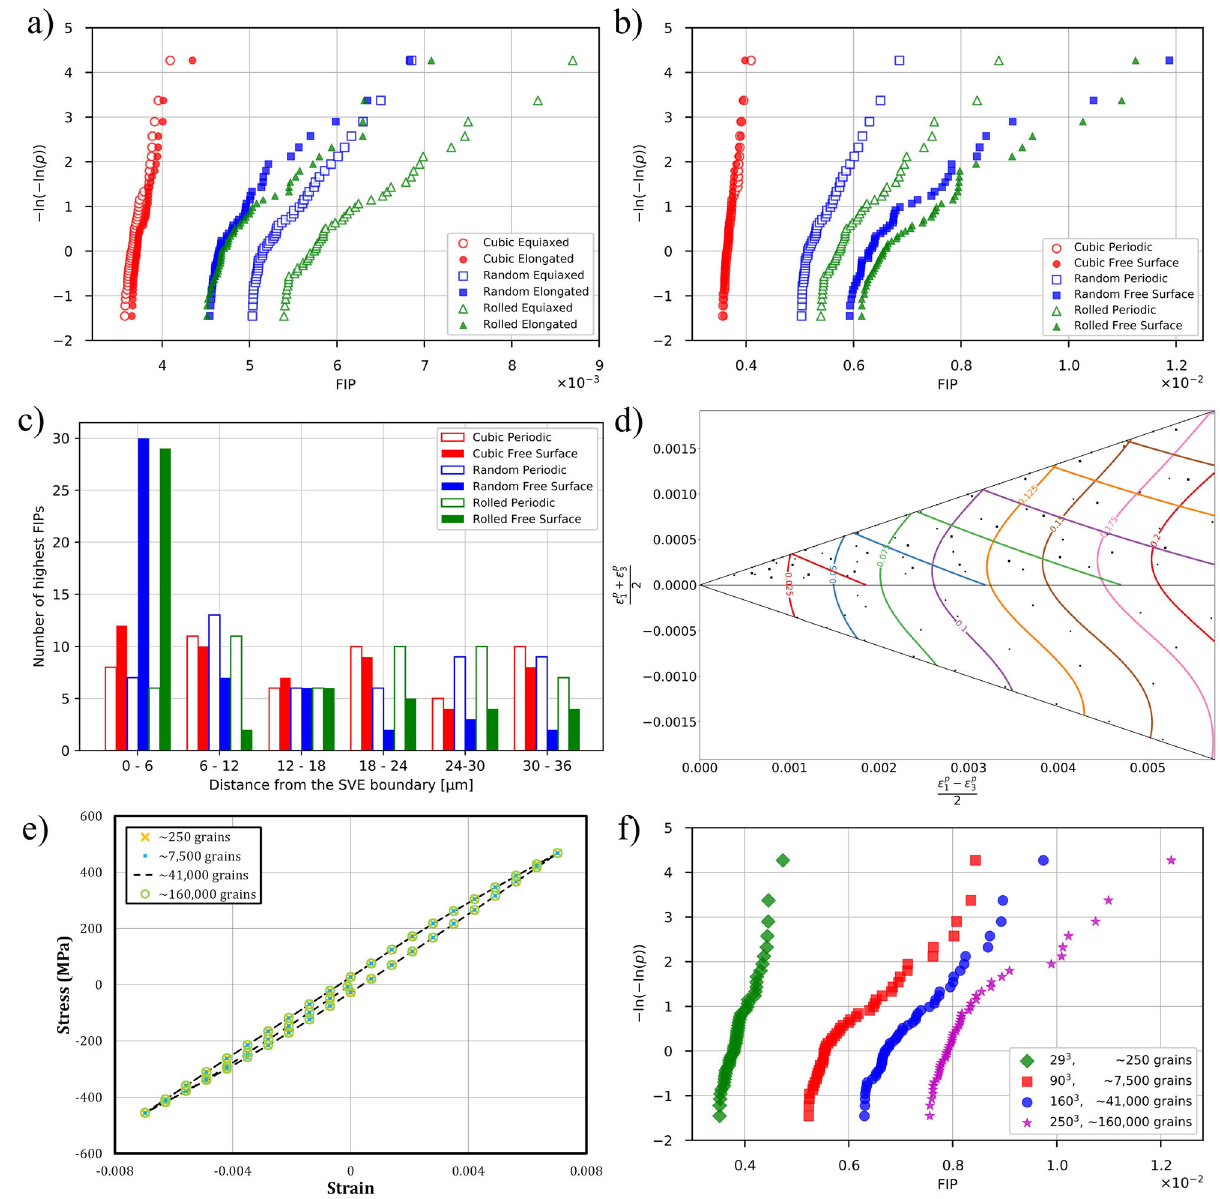
Fig. 3 Five different applications of PRISMS-Fatigue. In a, b , sub-band averaged FIPs are fi t to the Gumbel extreme value distribution (EVD). In a , FIP EVDs from microstructure ensembles with elongated grain morphology reduce FIP magnitudes. In b , the combined effects of crystallographic texture and boundary conditions show an increase in FIP magnitudes in the presence of a free surface for the random and rolled textures. c The 50 highest sub-band averaged FIPs from b are plotted as a histogram of the distance to the edge of the sample, which indicates that the highest FIPs manifest close to the free surface for the random and rolled textures. However, there is no correlation between the grains with high FIPs and distance to the edge of the sample in the case of periodic boundary conditions. Iso-FIP contours in d are shown on a multiaxial gamma ( Γ ) plane and cover a range of multiaxial strain states (uniaxial, equibiaxial, and pure shear) and amplitudes 17,55 . In e, f , the effect of sample size is investigated. In e , different size samples show indistinguishable stress-strain responses. However, in f , the FIP EVDs strongly depend on the sample size such that FIPs from the larger microstructures progressively increase and shift to the mean free slip path in the elongated grains. The applications distributed throughout the microstructure; this decreases the entitled Texture_Effect_Al7075T6 and GrainMorphology_Effec- probability of a single slip system with substantial slip. Conversely, t_Al7075T6 on Materials Commons contain the required informa- both random and rolled textures exhibit higher FIP EVDs. Grain tion to perform these or similar simulations in PRISMS-Fatigue. morphology in the cubic-textured SVEs does not considerably The fatigue response of certain alloys is more sensitive to local change the FIP EVDs. However, in the random and rolled textures, micromechanical response near a free surface. Elastic/plastic grain elongation considerably decreases the FIP EVDs (Fig. 3a). It is anisotropy, surface condition, and applied strain play a strong important to note that the equiaxed and elongated grain SVEs role. For instance, in the lower crystal symmetry hcp titanium alloy contain the same nominal number of grains (i.e., grain volumes Ti-6Al-4V, fatigue crack initiation (FCI) was observed more than are similar). Thus, the lower values of these FIPs may be a 500 μ m below the specimen surface in the HCF regime but consequence of plastic shear strain constraints due to the reduced